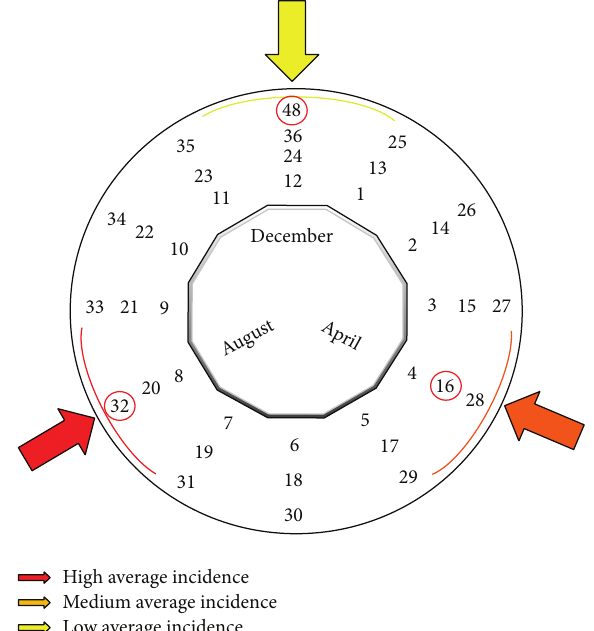
Figure 4: Classes of monthly relative (sqrt) incidence of Amer- ican Tegumentary Leishmaniasis cases in Department of Or´an,